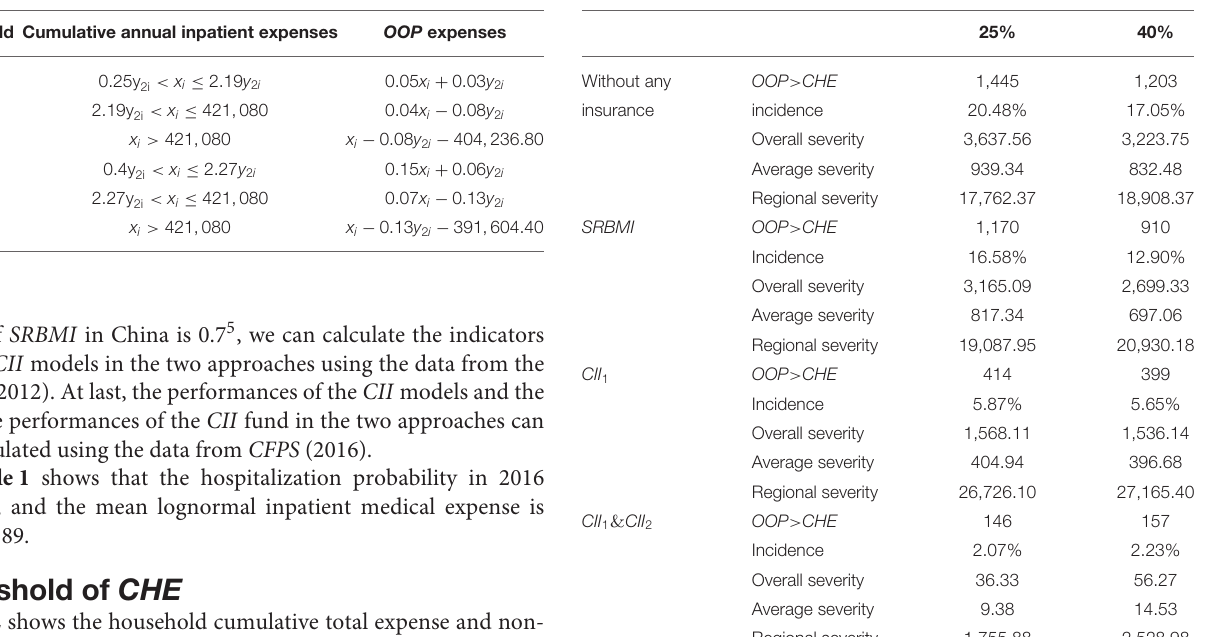
TABLE 9 | Household cumulative OOP expenses in the ATP approach. TABLE 10 | Performance evaluation of the CII model in the ATP approach.